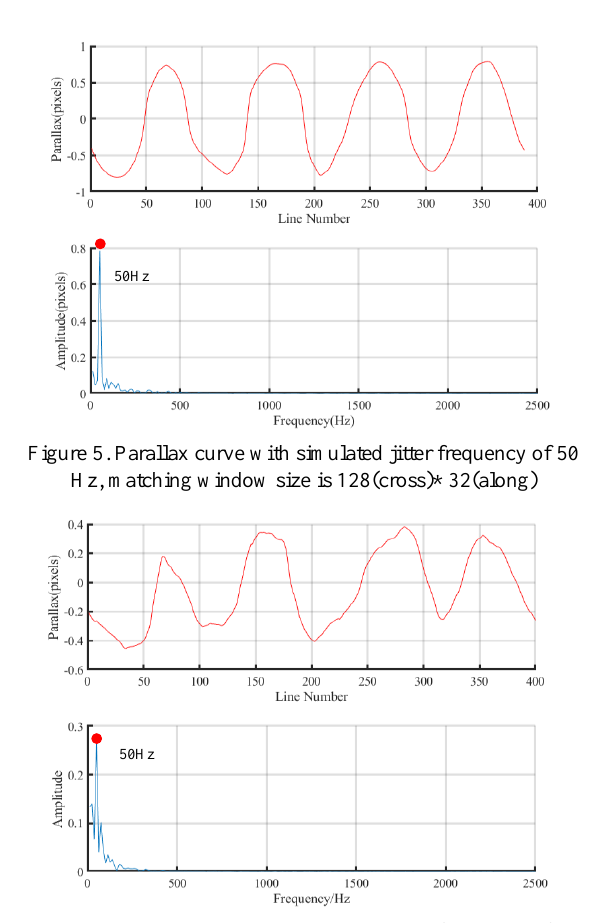
Figure 9. Parallax curve with simulated jitter frequency of 1250 Hz, matching window size is 128